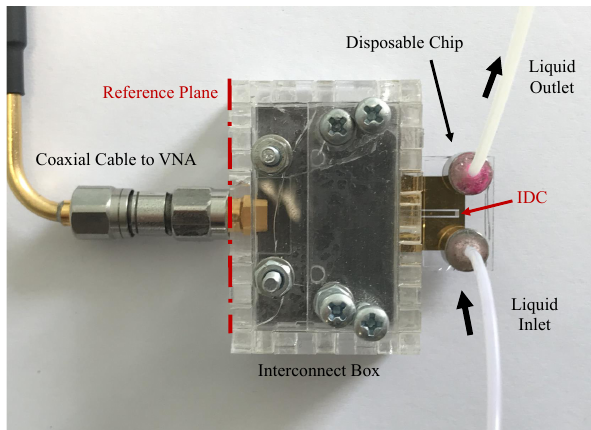
Figure 2. Photograph of the measurement setup with the quartz consumable chip mounted in the ICB.